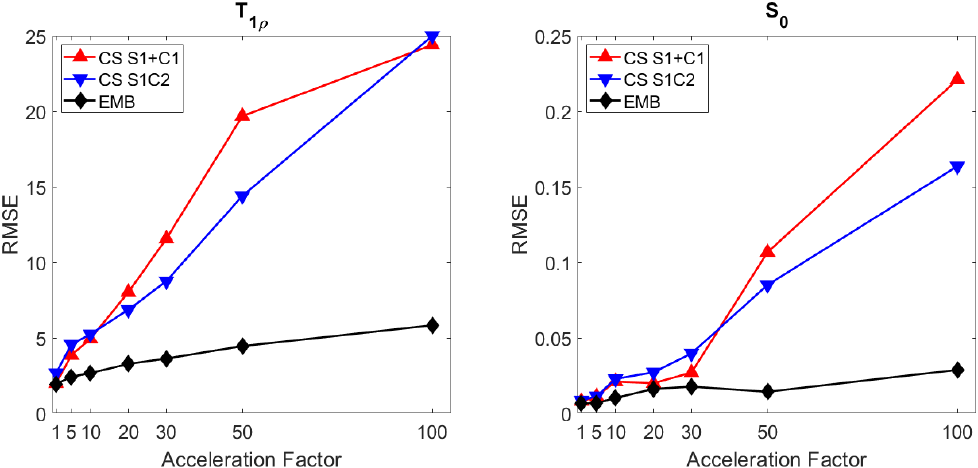
Figure 6. The RMSEs of the T 1 ρ ( left ) and S 0 ( right ) maps of the radial simulation with the embedded model and the two CS models at acceleration factors 1, 5, 10, 20, 30, 50, and